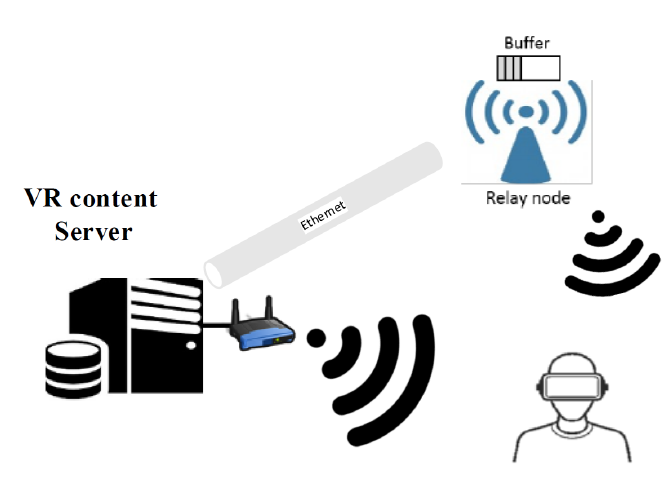
Figure 5. Advances of mmWave VR system using relay node.